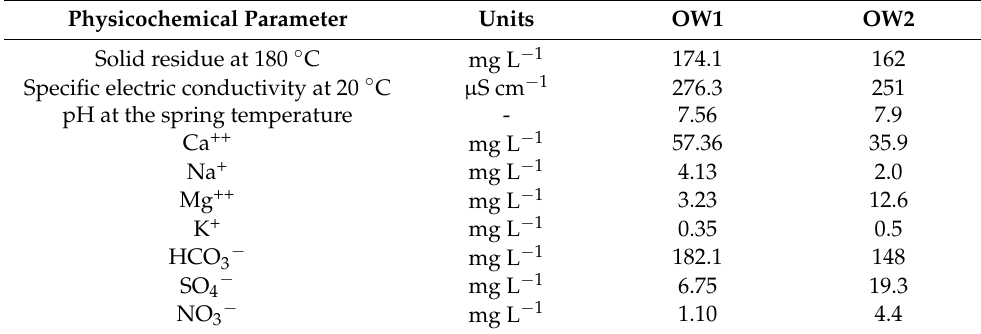
Table 1. Values of the physicochemical parameters reported on the labels of the bottled mineral waters considered in this